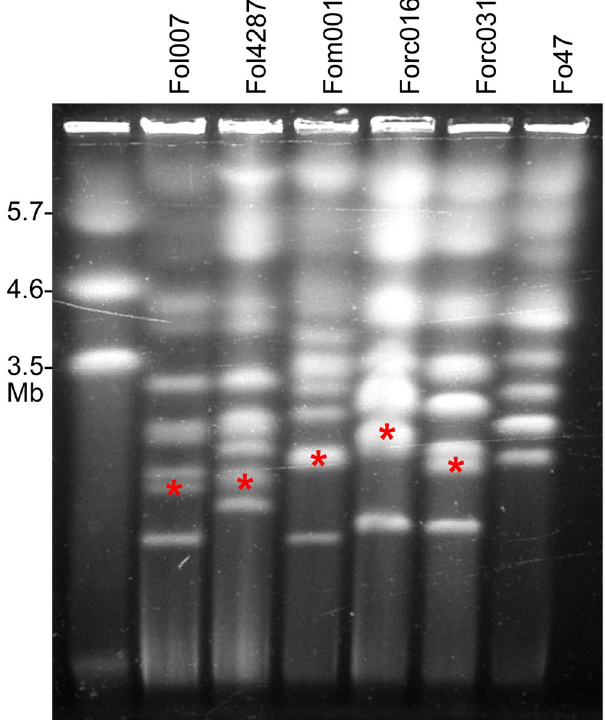
Figure 1. Electrophoretic karyotypes of strains belonging to F . oxysporum f.sp. lycopersici (Fol007, Fol4287), melonis (Fom001) or radicis - cucumerinum (Forc016, Forc031) and non-pathogenic strain Fo47. A red asterisk indicates the location of the radioactive Fol- SIX6 probe hybridization signal, identifying the chromosomes potentially involved in pathogenicity. Fo47, a non-pathogenic strain, does not have a SIX6 homolog. The left lane shows the karyotype of Schizosaccharomyces pombe , applied as a marker. This image is cropped, the original gel photograph can be found in Supplementary Fig.